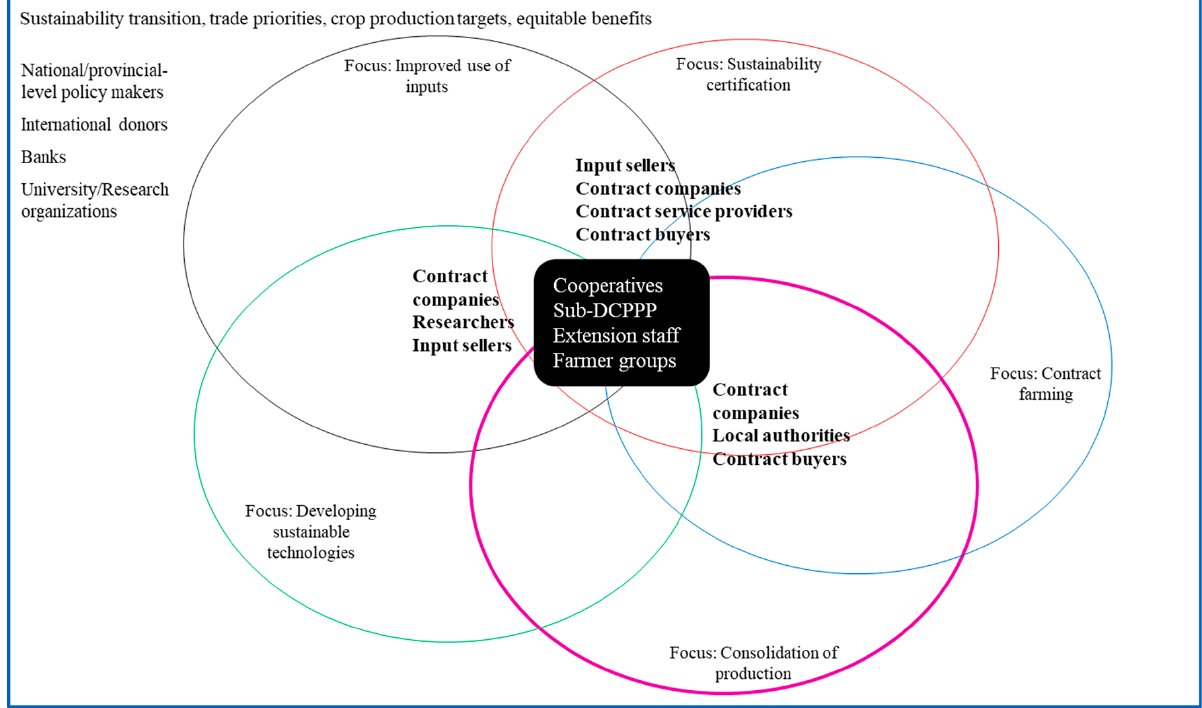
Figure 5. Convergence of socio-technical systems, each focused on a specific shared interest, with linked intermediaries and set in a broader context that supported the uptake of 1 Must Do, 5 Reductions (1M5R) in the Mekong Delta region of Vietnam.